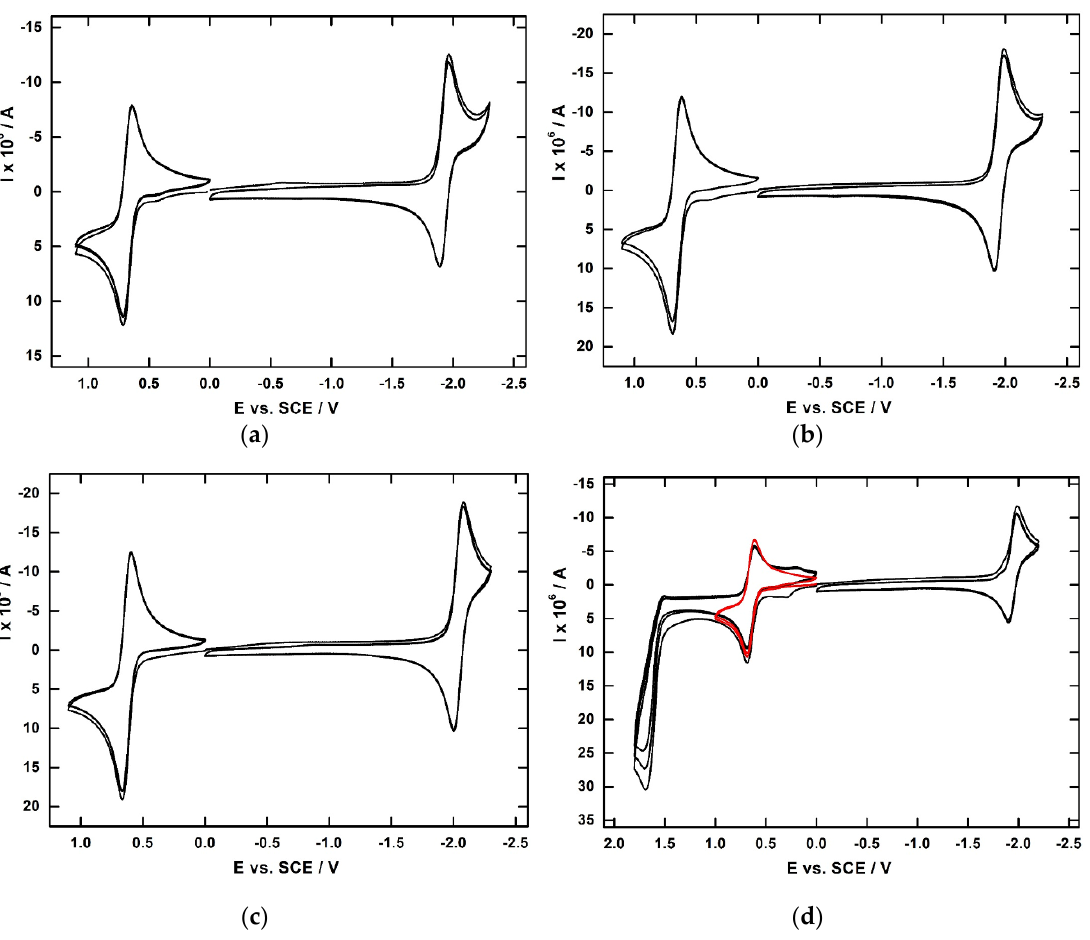
Figure 1. Cyclic voltammetry acetonitrile of compounds 1 ( a ), 2 ( b ), 3 ( c ) and 4 ( d ) containing 0.1 M Bu 4 NPF 6 at glassy carbon electrode. v = 100 mV ∙ s − 1 .